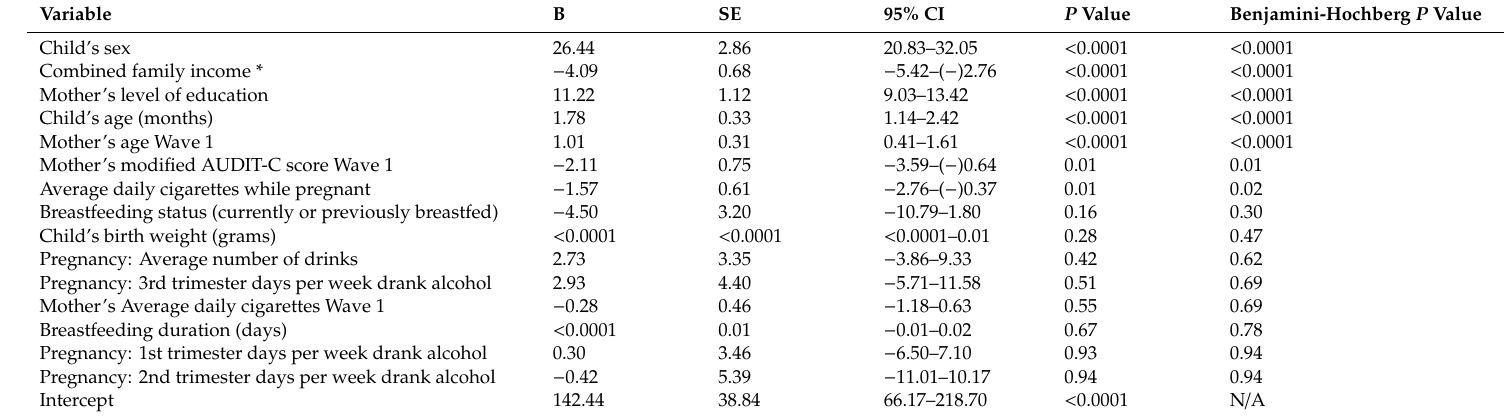
Table 6. Grade 3 NAPLAN grammar and punctuation scores (babies who had been breastfed at any